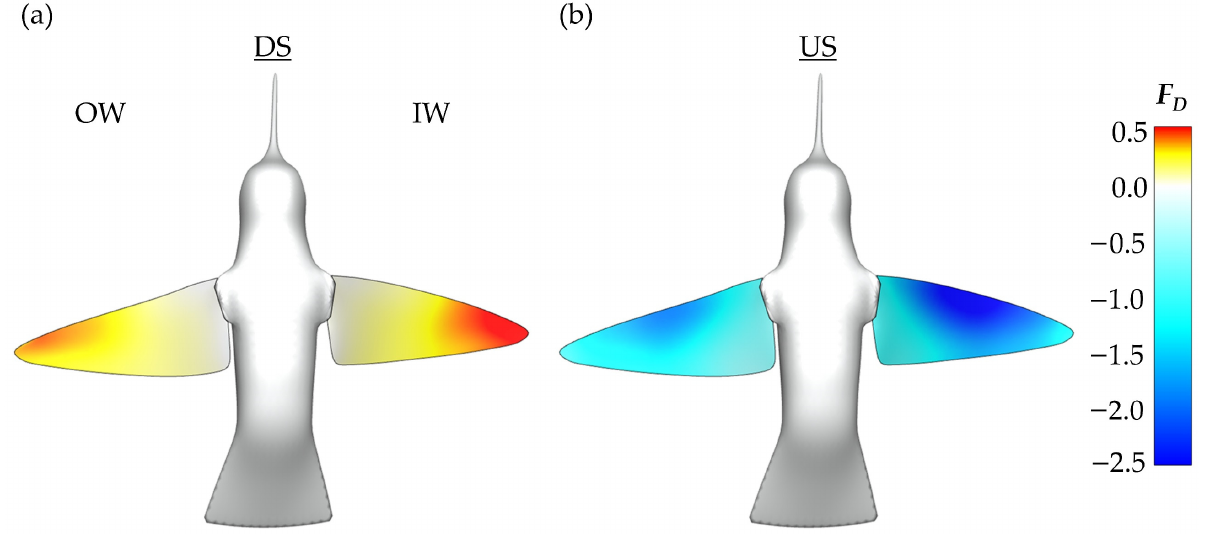
Figure 7. ( a ) Phase II, ‘turning phase’, average DS and ( b ) average US non-dimensional drag forces produced by the